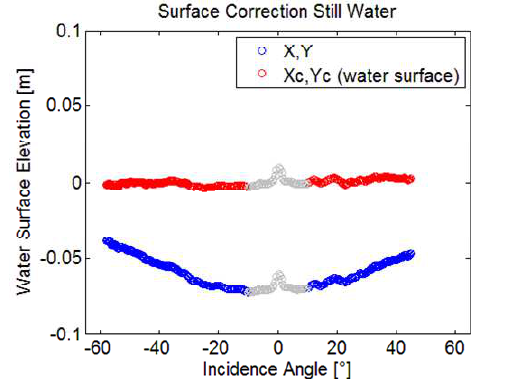
Figure 7: Still water surface profile before (blue), and after (red) surface